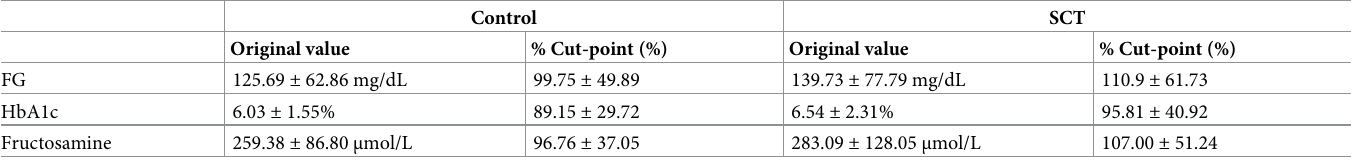
Table 2. Biomarkers of hyperglycemia by